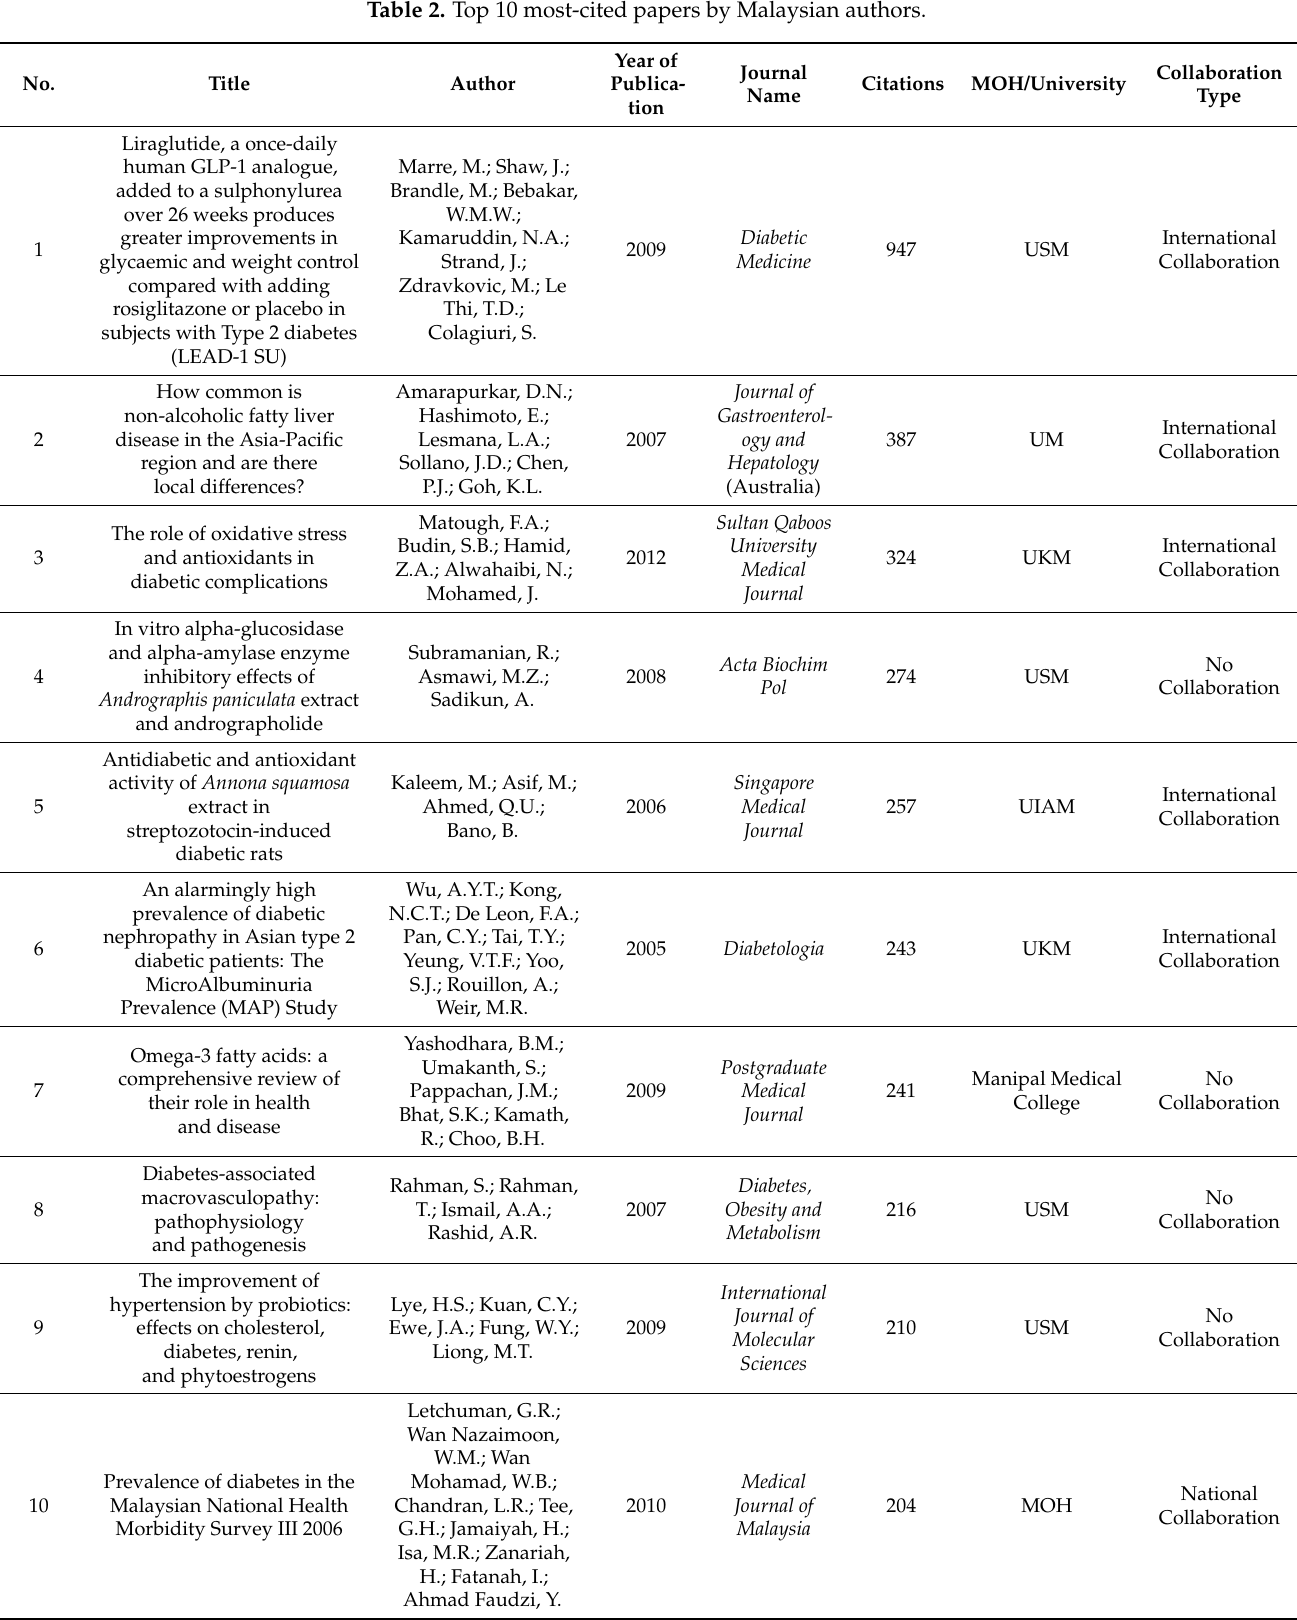
Table 2. Top 10 most-cited papers by Malaysian